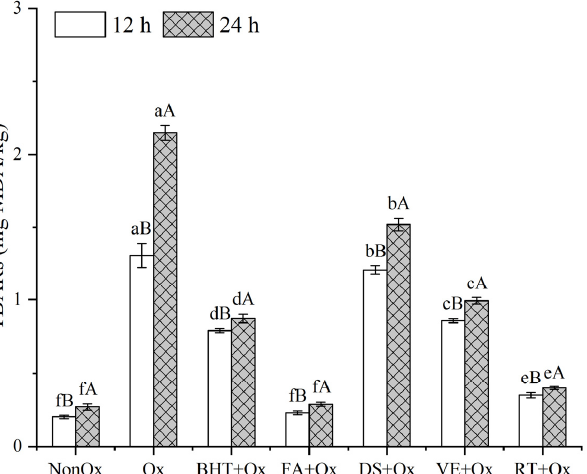
Figure 1. TBARs value of minced yak meat supplemented with different antioxidants. Note: NonOx—non-oxidized; Ox: oxidized without antioxidant; BHT + Ox, FA + Ox, DS + Ox, VE + Ox, and RT + Ox—oxidized in the presence of BHT, ferulic acid, diallyl sulfide, α -tocopherol, and rutin, respectively. a–f Means with different lowercase letters are significantly different among antioxidant treatments for the same oxidation time ( p < 0.05); A–B Means with different uppercase letters are significantly different between 12 and 24 h for the same antioxidant treatment ( p < 0.05).